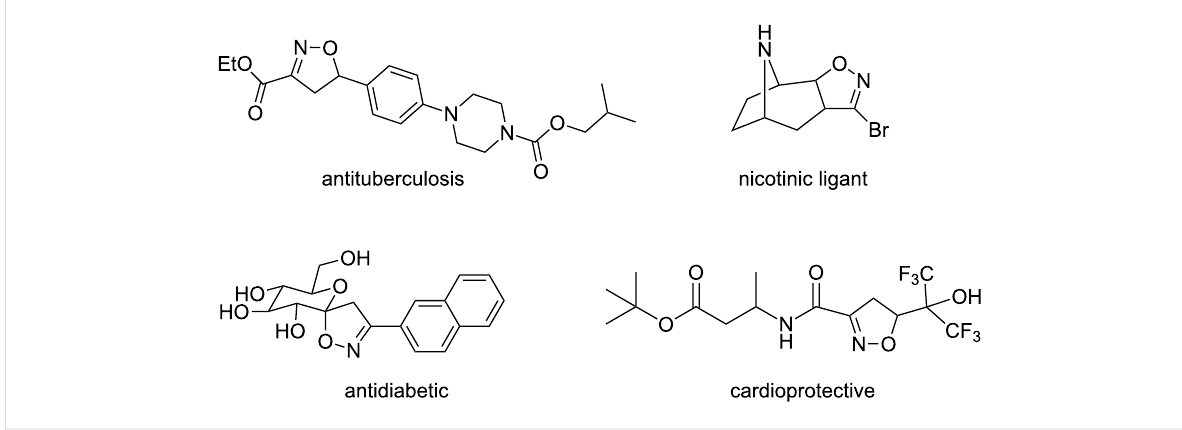
Figure 1: Example of bioactive molecules bearing the 2-isoxazoline nucleus.